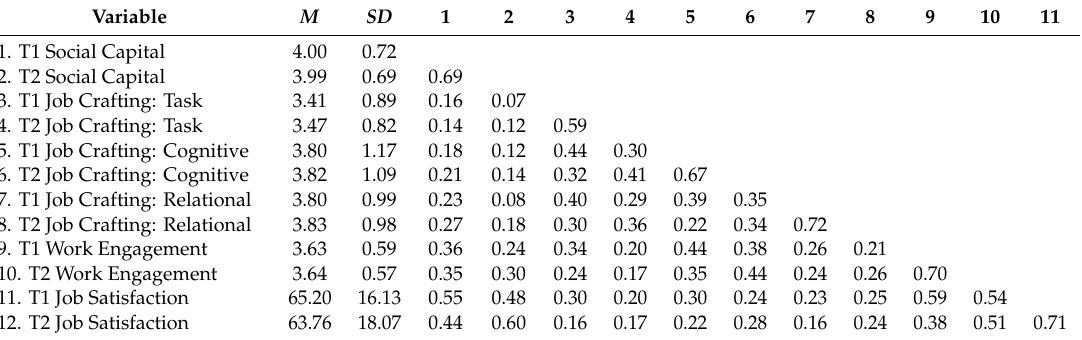
Table 1. Intercorrelations, mean values (M), and standard deviations (SD) of study variables ( n = 250). Variable M SD 1. T1 Social